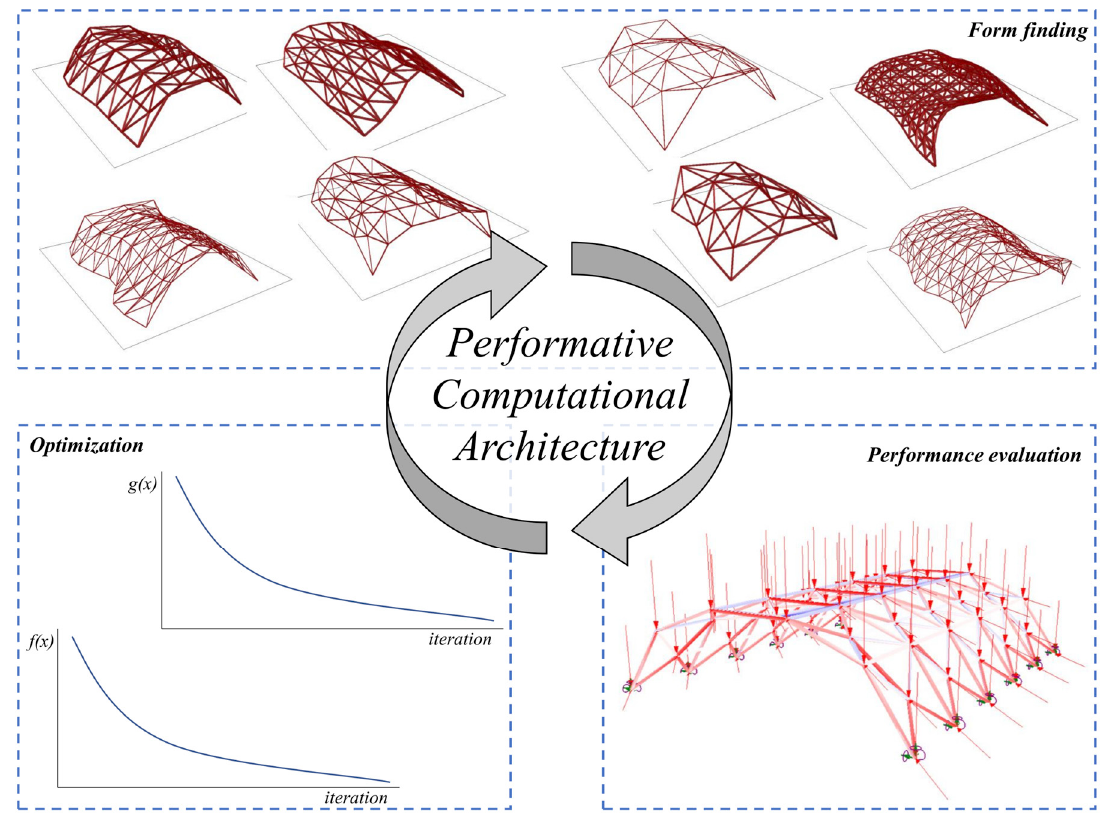
Figure 1. Performative computational architecture (PCA) framework.